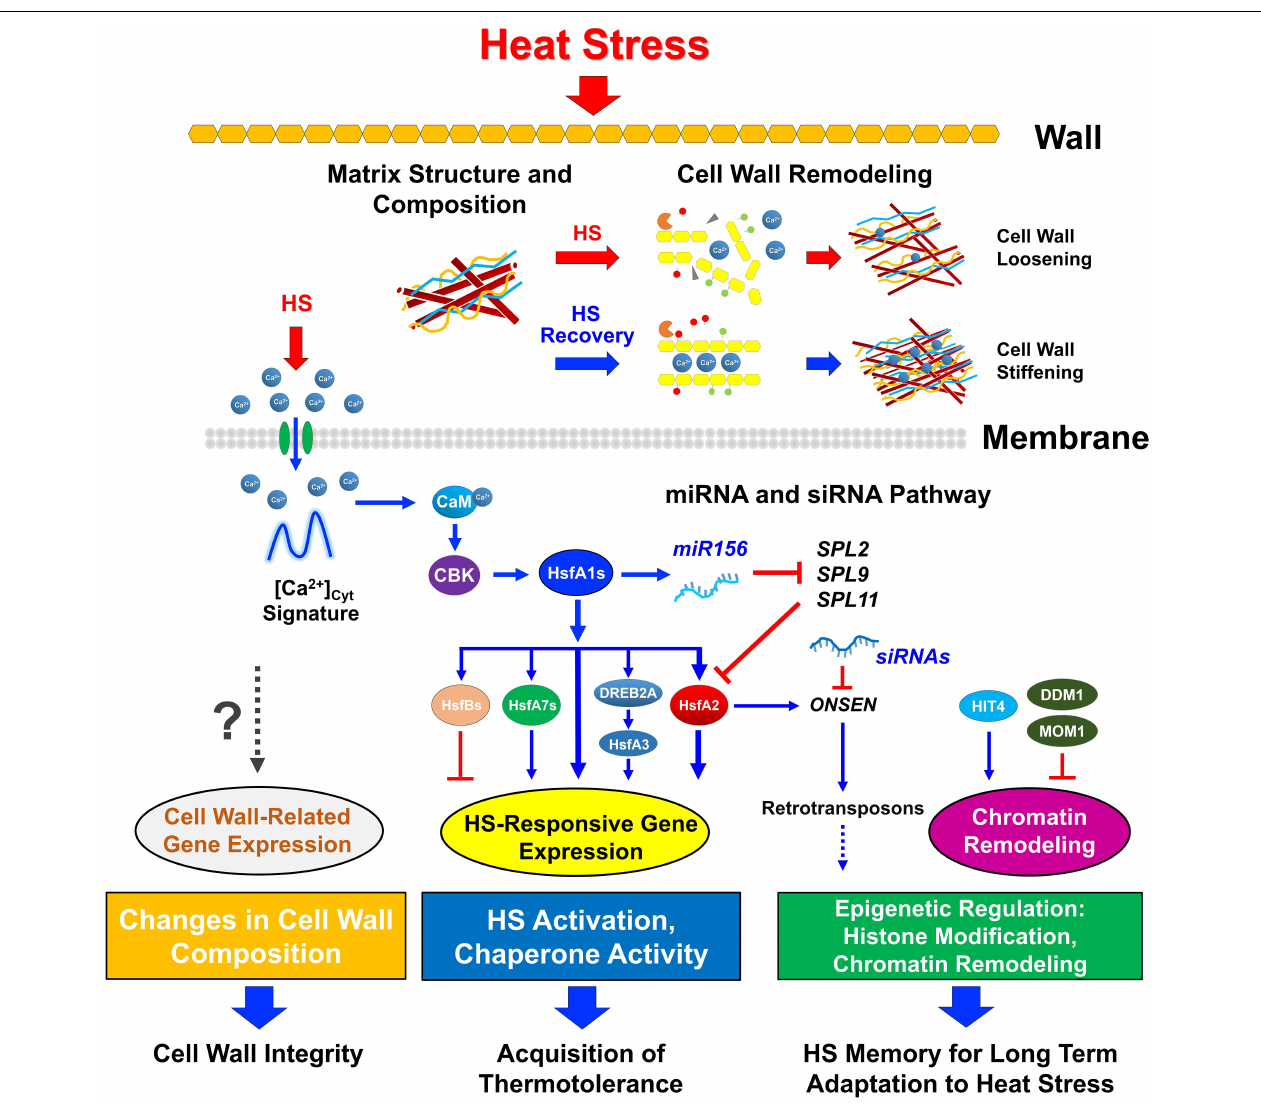
FIGURE 1 | Integration of cell wall remodeling and the heat response network. Plant perception of heat involves several pathways in different compartments. The cell wall is the first protective barrier in plants that is exposed to heat. Heat stress (HS)-triggered pectin methylesterases (PME) activity, accompanied by Ca 2 + mobilization from apoplastic sources, is involved in cell wall remodeling and is crucial for plant thermotolerance. During recovery time after HS, PME performs linear demethylesterification on highly esterified pectin residues and interacts with Ca 2 + to form a pectate gel lawn, which causes cell-wall stiffening. During non-lethal HS, acidic PME acts randomly on pectin and promotes the action of endo-polygalacturonases (PG) to contribute to cell-wall loosening and the release of Ca 2 + through Ca 2 + -permeable channels (green oval) in the plasma membrane, thus causing a transient increase in [Ca 2 + ] cyt oscillation. This is followed by induction of a Ca 2 + /calmodulin (CaM)-dependent pathway to activate the master HS regulator HsfA1s, which directly triggers HS-responsive transcription factors, including HsfA2, HsfA7s, HsfBs, and dehydration-responsive element-binding protein 2A for downstream HsfA3 and HSP gene expression involved in the acquisition of thermotolerance. Histone modification and several epigenetic regulators, including small RNAs and transposons, are involved in the HSR and HS memory. MicroRNA156 targets the SQUAMOSA promoter-binding protein-like gene family, which downregulates HS-inducible genes and therefore maintains the expression of HsfA2 and HSP genes during recovery from HS for long-term adaptation to HS. The retrotransposon ONSEN, as a target of HsfA1s and HsfA2 , can be modulated by siRNAs for the regulation of HS memory. Through heat-intolerant 4 (HIT4), HS can relax the silencing of transposons, whereas they can be silenced by deficient in DNA methylation 1 (DDM1) and Morpheus’ molecule 1 (MOM1). However, the HS-induced cell wall-related transcript profile needs to be further explored with regard to the maintenance and modification of cell wall